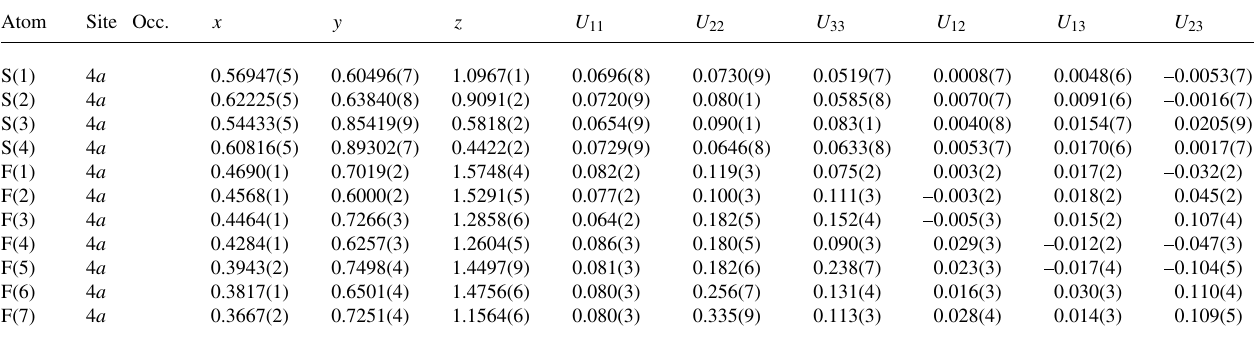
Table 3. Atomic coordinates and displacement parameters (in Å 2 ) . Atom Site Occ.